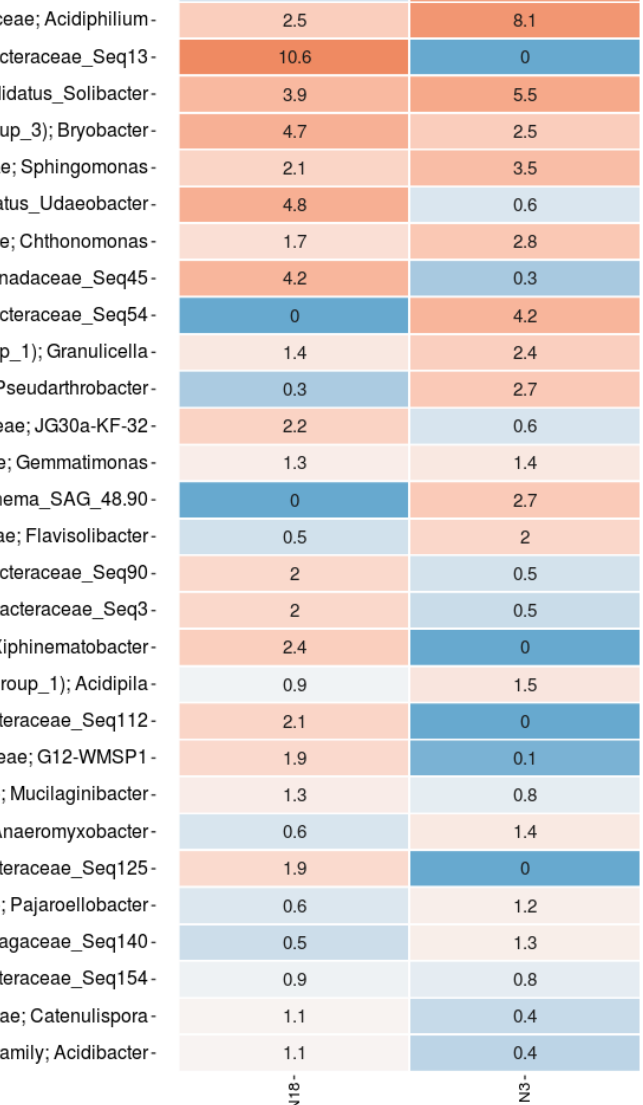
Figure 9: Heatmap of the 30 most abundant phylotypes for samples N18_W and